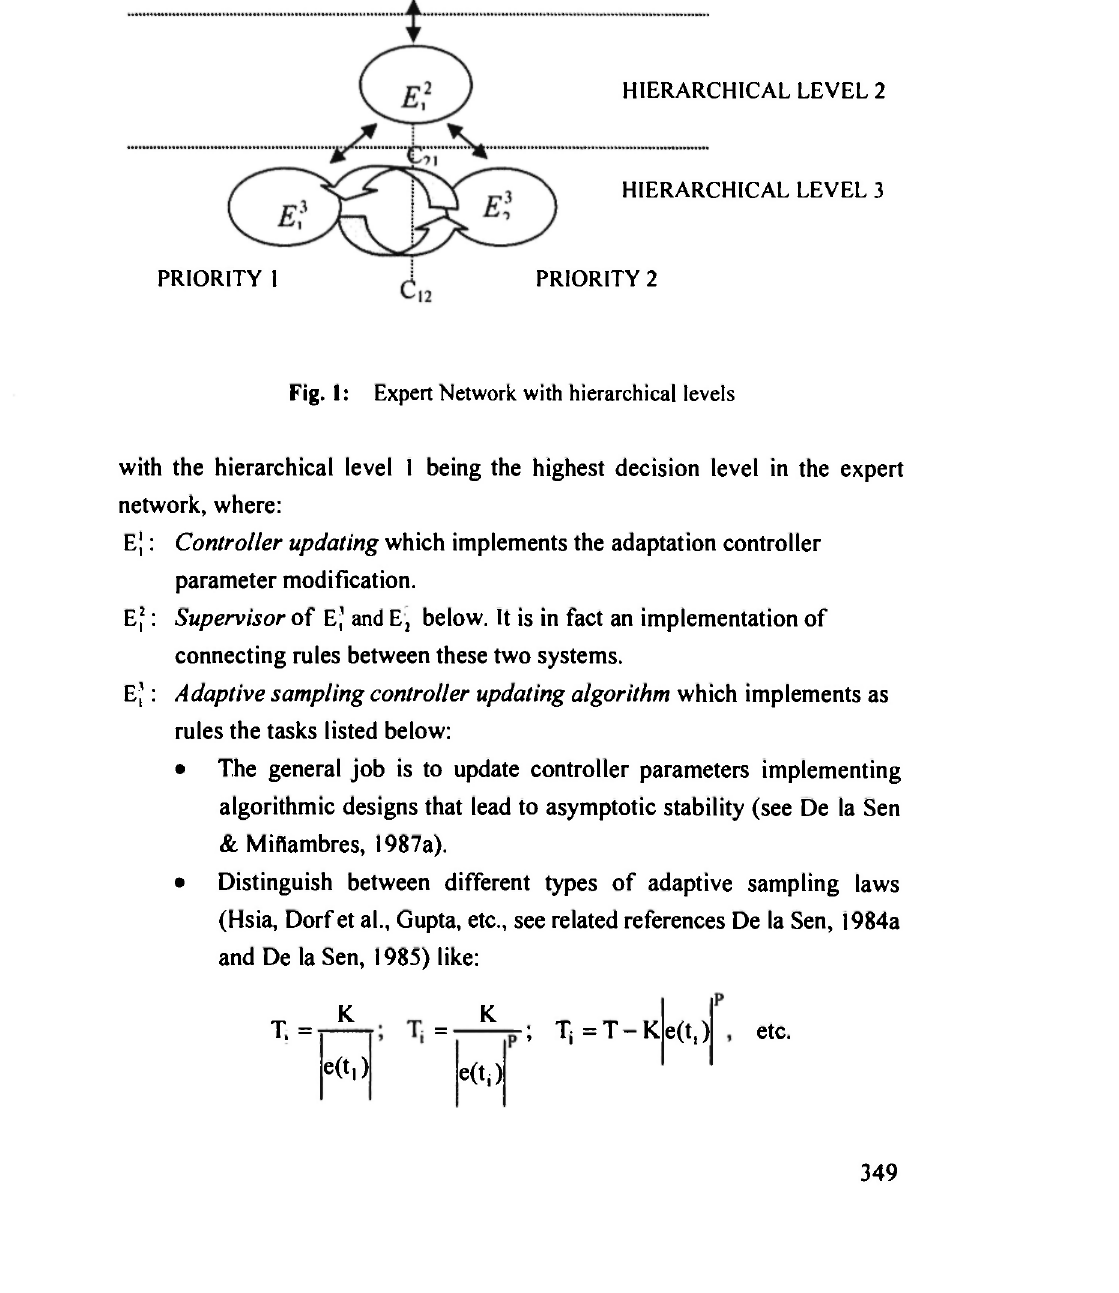
Fig. I : Expert Network with hierarchical